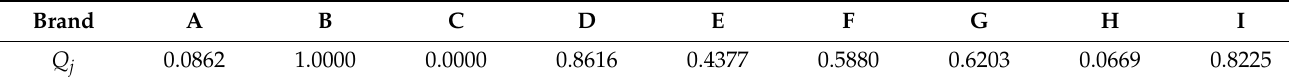
Table 4. The function evaluation value Q j.